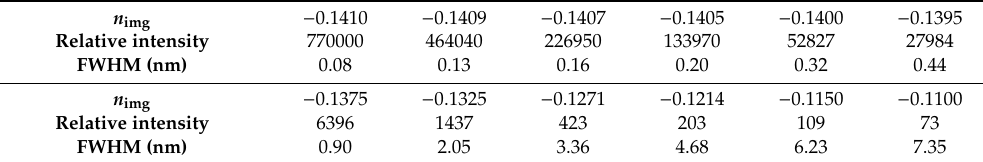
Table 2. Relative intensity and FWHM for DC = 50% at di ff erent gain values. n